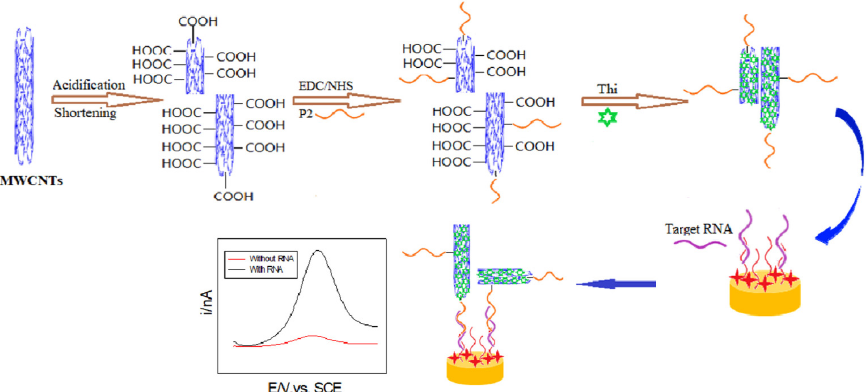
Figure 20. Scheme for synthesis and conjugation of thionine-loaded S-MWCNTs with DNA and formation of sandwich assay for miRNA. Adapted with permission from Deng et al. [129] (copyright © (2018), Elsevier).